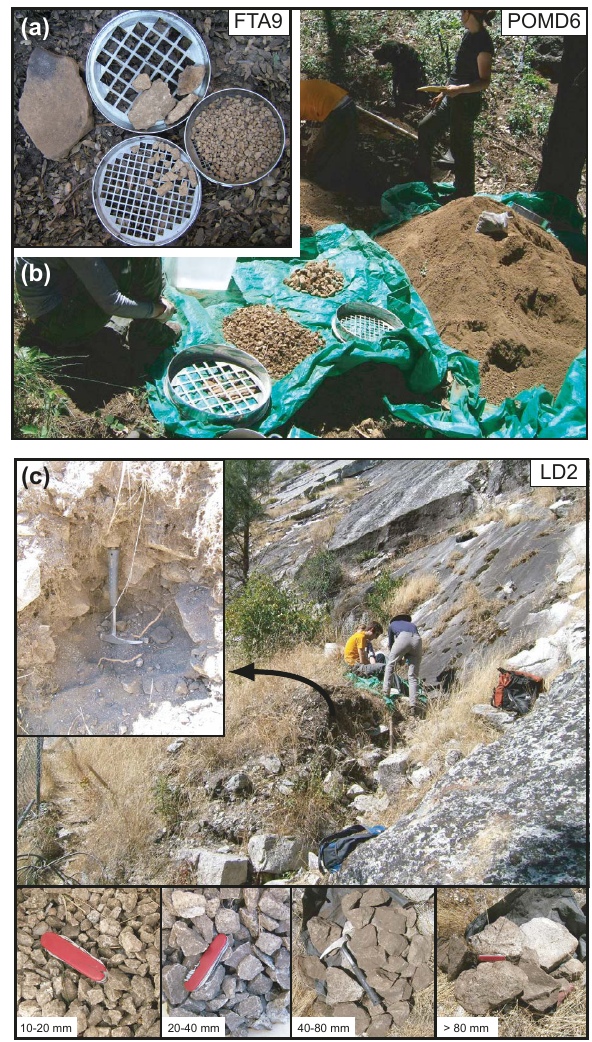
Figure 4. Photographs of hillslope sites (see Fig. 3 for location of sites). Panels (a) and (b) : sediment at soil sites and 10, 20 and 40mm square mesh sieves. (a) Sediment coarser than 10mm at site FTA9 (transition zone); clasts are fresh and angular and show lit- tle evidence of chemical weathering. (b) Sediment at site POMD6 (plateau), including 540kg of sediment finer than 10mm (heap to the right), and 7.5 and 3.0kg of clasts in the fractions 10–20 and 20– 40mm, respectively (on the tarpaulin). (c) Sediment at the landslide site LD2. Upper panel: overview with close-up of pit (inset). Lower panel: different sediment fractions extracted from the pit. Hammer is 300mm long. Swiss army knife is 90mm